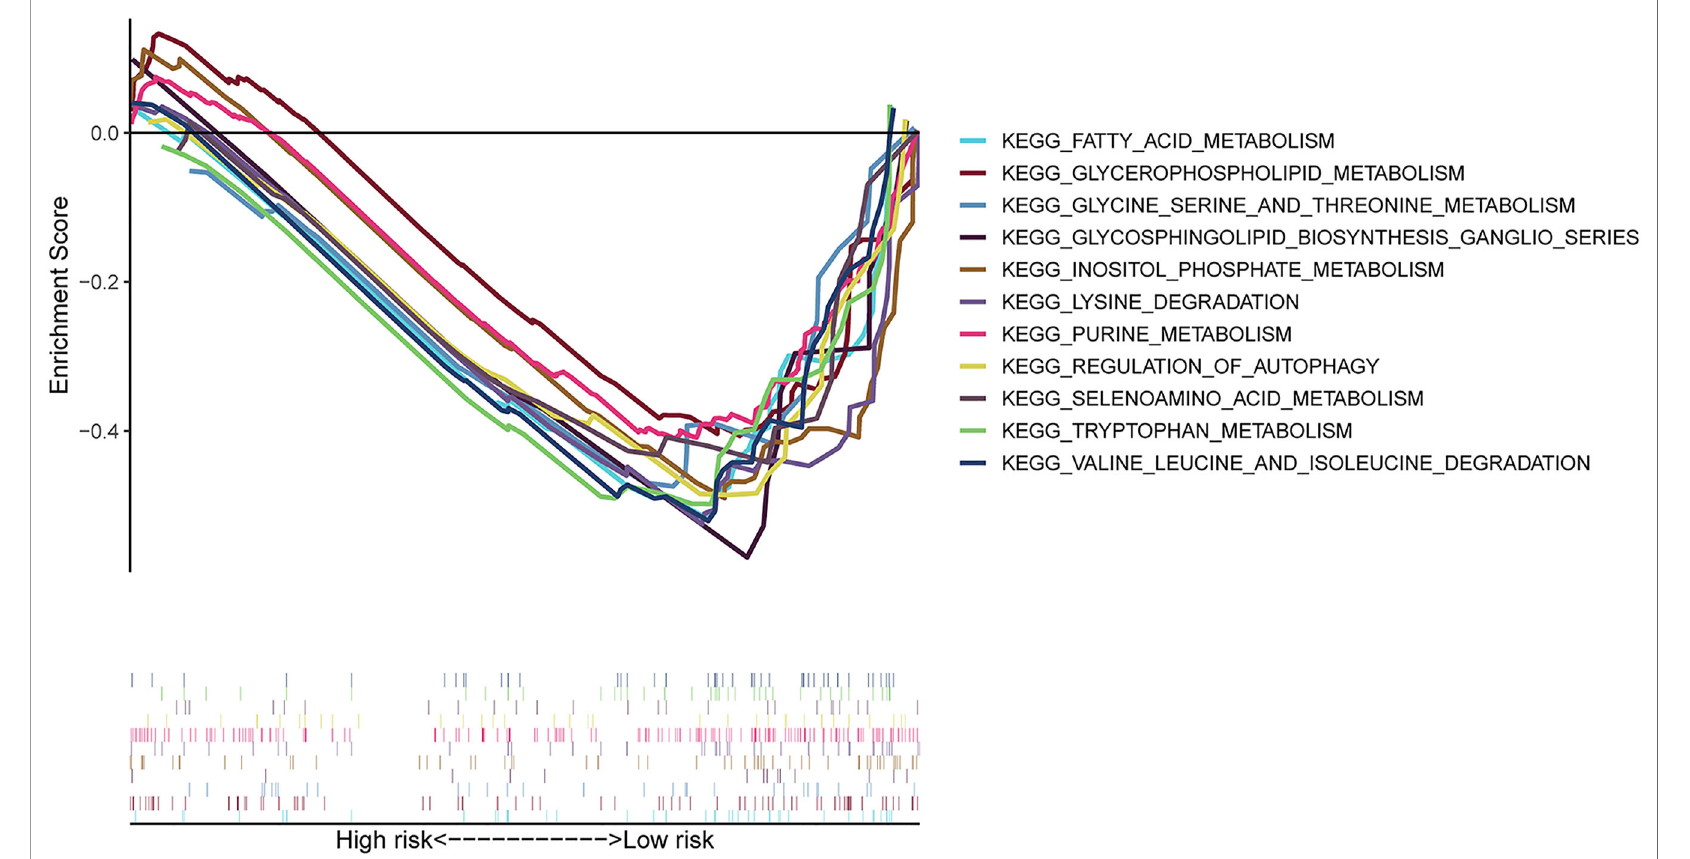
FIGURE 5 | GSEA between high- and low-risk groups based on the identi fi ed risk score system. GSEA result indicated that the autophagy-related and metabolic pathways were signi fi cantly enriched in the low-risk